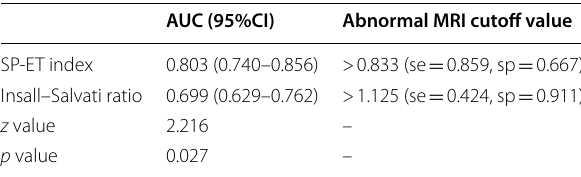
Table 4 The results of ROC analysis of the SP-ET index and Insall–Salvati